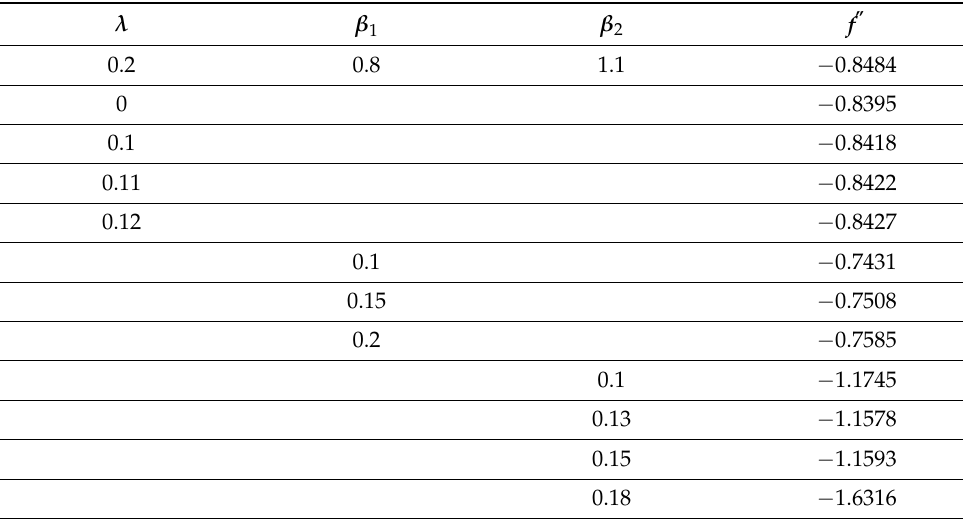
Table 3. The numerical values of f (cid:48)(cid:48) with respect to pertinent varied parameters.